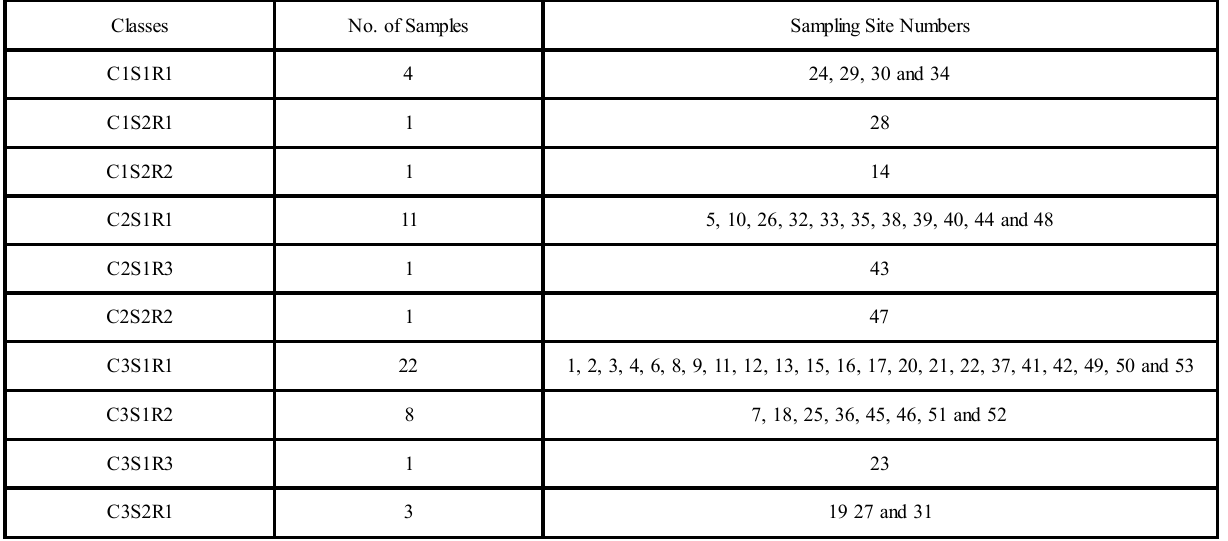
TABLE 4. GROUNDWATER QUALITY CLASSES OF TALUKA MITHI AND